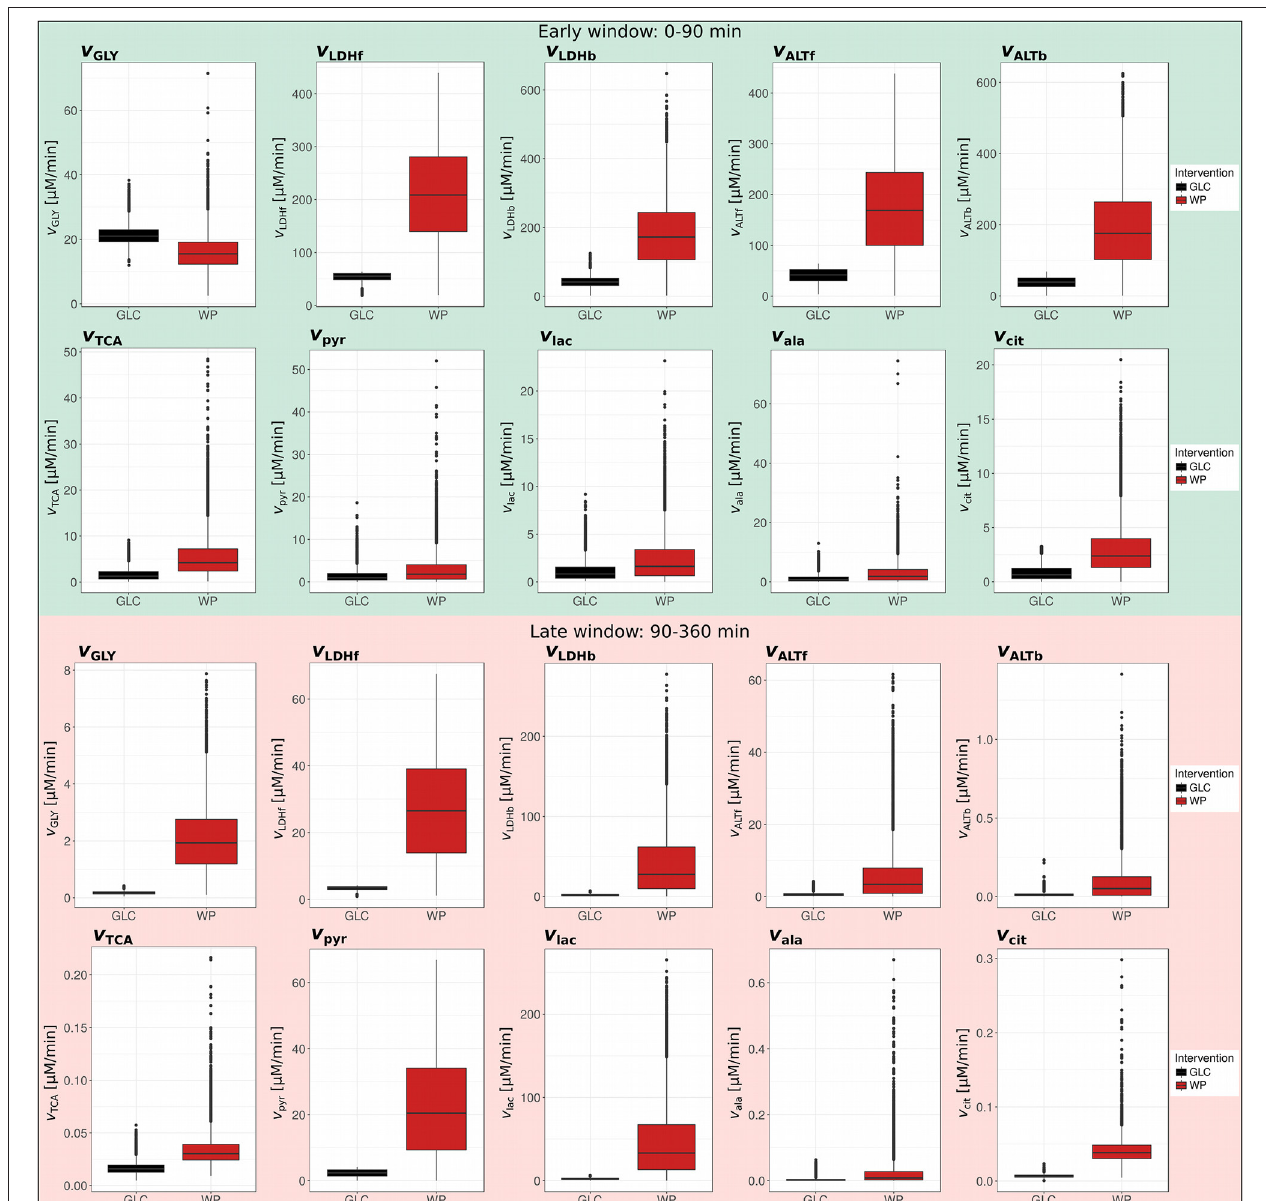
FIGURE 4 | Postprandial metabolic fluxes in the early and late window. Boxplots of simulated postprandial metabolic fluxes in GLC and WP obtained for the early (0–90min) and late (90–360min) postprandial phase (GLC, black; WP, red; n = 10,000).